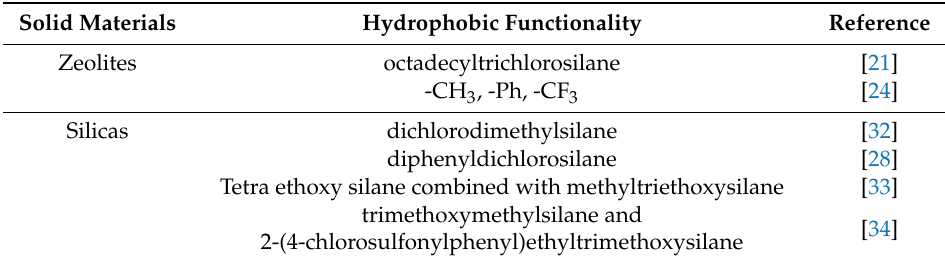
Table 3. Hydrophobic functionalizations for zeolites and silicas